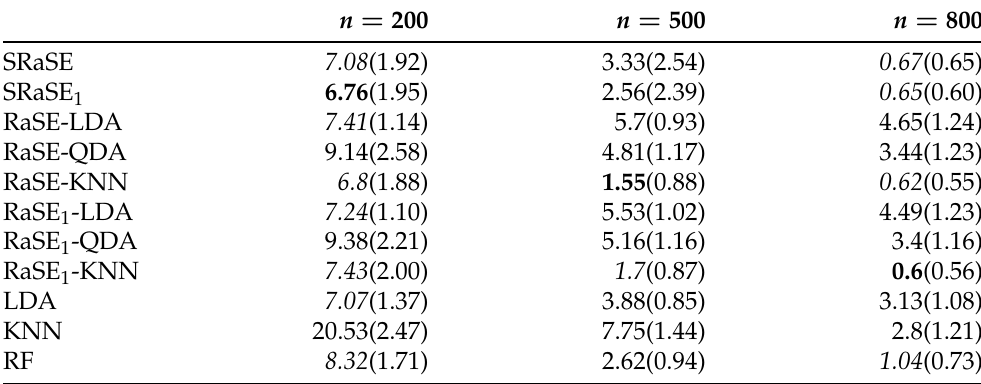
Table 4. Summary of test classification error rates for each classifier under various sample sizes over 200 repetitions for the mice protein expression data set. The results are presented as mean values with the standard deviation values in parentheses. Here, the best performing method in each column is highlighted in bold and the methods that are within one standard deviation away are highlighted in